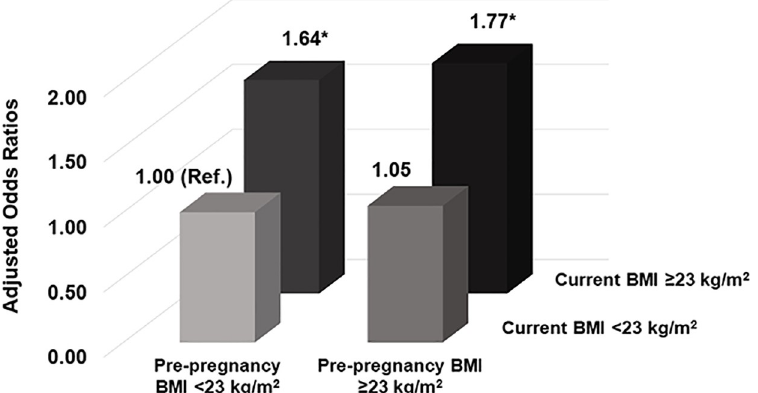
Fig 2. Associations of pre-pregnancy BMI and current BMI with the development of type 2 diabetes in the in the Health Examinee Study (HEXA) 2004–2013. Data are presented as adjusted odds ratios after controlling for age (continuous), education ( � high school, vocational school, graduate or college dropout, � college), income ( < 1 million Korean won, 1–2 million Korean won, 2–3 million won, � 3 million Korean won), smoking status before the first pregnancy (no, yes), alcohol consumption (never, past, current), regular exercise (no, yes), menarche age ( � 14, 15, and � 16 years), first pregnancy age ( � 23, 24–26, and � 27 years), and first pregnancy outcome (live birth, stillbirth, extrauterine pregnancy, spontaneous abortion, artificial abortion). � P value < 0.05. BMI: Body mass index.